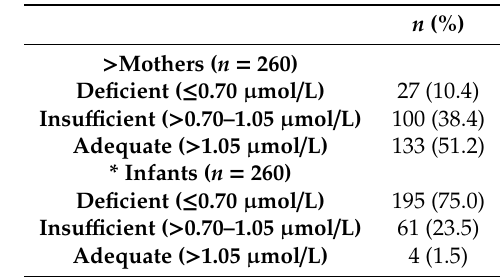
Table 3. Retinol status of mothers and infants.